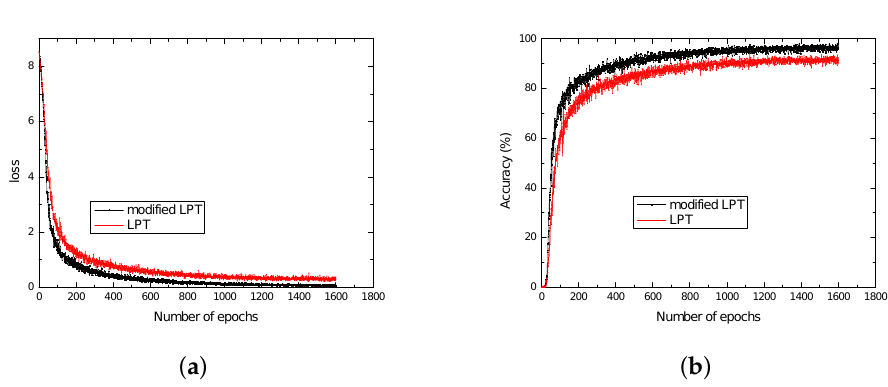
Figure 4. ( a ) Loss vs. the number of epochs. ( b ) accuracy vs. the number of epochs.